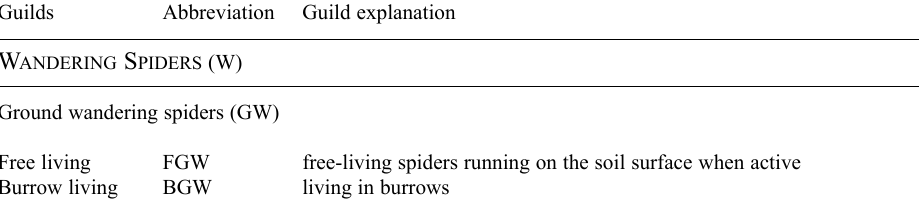
Guild classification of spiders collected in the Kruger National